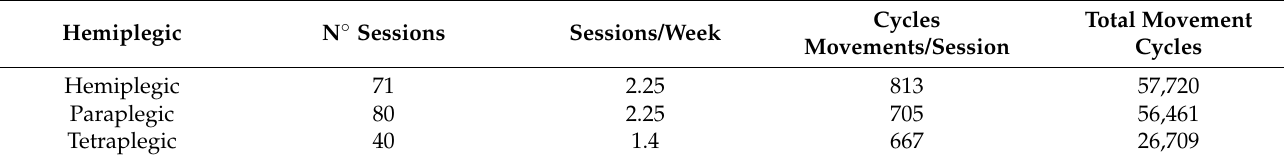
Table 2. Rehabilitation treatment data (averages for hemiplegic, paraplegic and tetraplegic groups). Hemiplegic N ◦